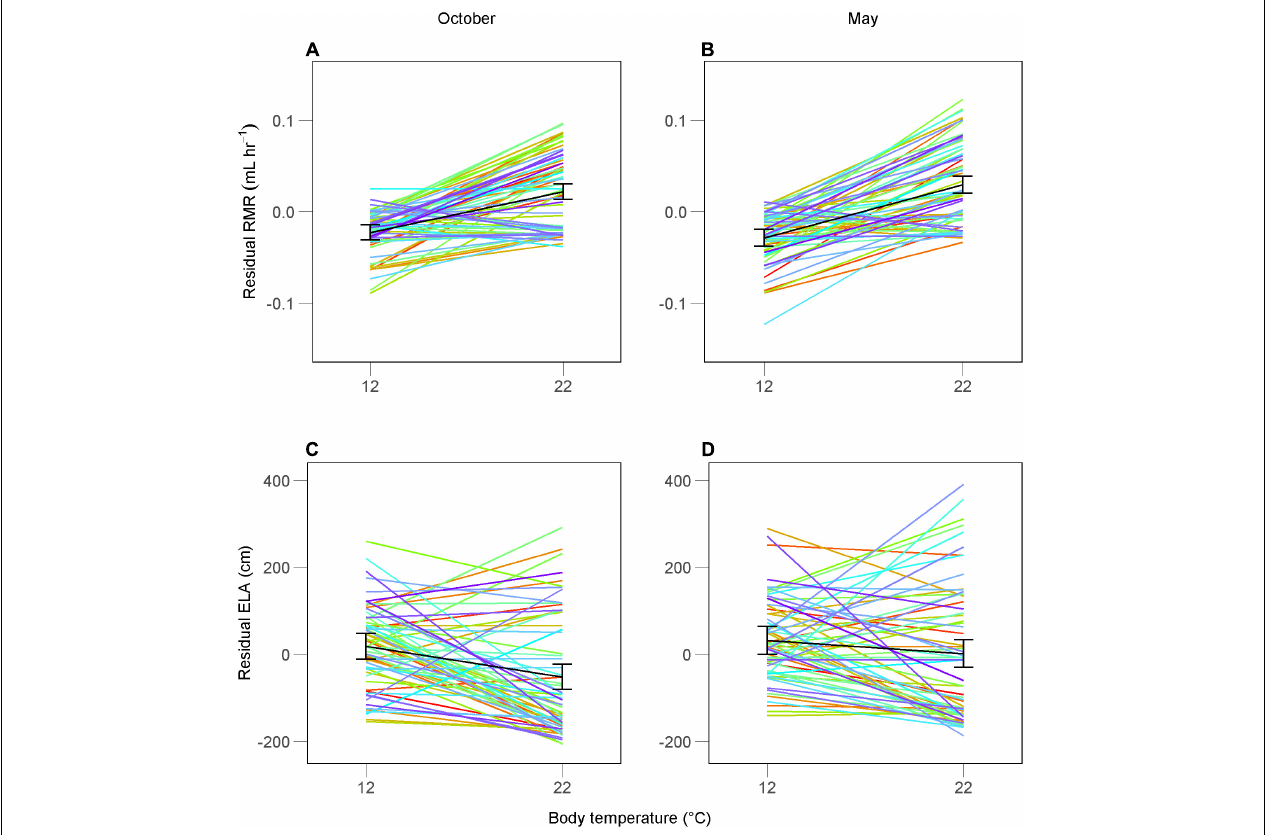
FIGURE 1 | Repeated measurements of mass-adjusted resting metabolic rate (RMR; A,B ) and exploratory locomotor activity (ELA; C,D ) in juvenile Alpine newts ( Ichthyosaura alpestris ) at two body temperatures between October and the following May. Each line shows values for one individual, while the black line shows the population mean (95% CI). Values were standardized to zero mean and divided by the sample standard deviation to allow variance comparison between